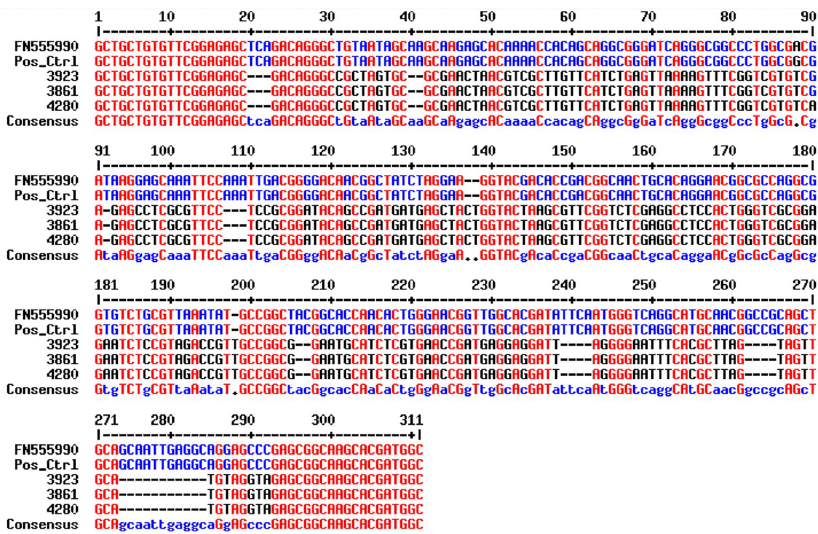
Fig 5. Results of the sequence alignment of the three samples sent for sequencing (3923, 3861 and 4280) against the T . b . gambiense positive control (Pos_ctrl) and reference sequence (FN555990) from the NCBI database. Image generated using MultAlin